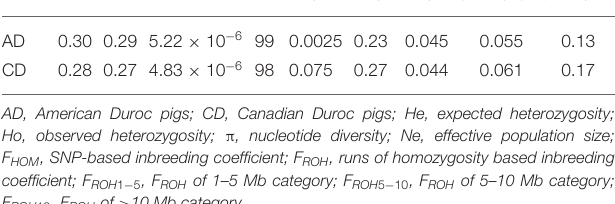
TABLE 1 | Genetic diversity of Duroc pigs. Lines He Ho